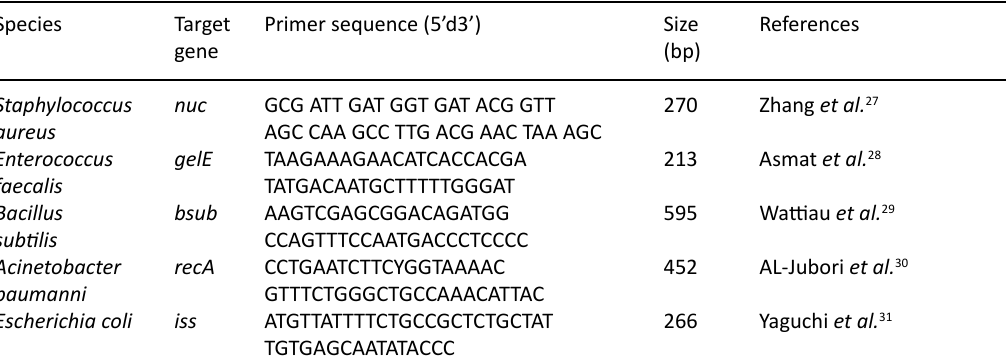
table 1. Primer sequences, target genes and amplicon sizes of certain virulence genes of the most frequently isolated airborne bacteria